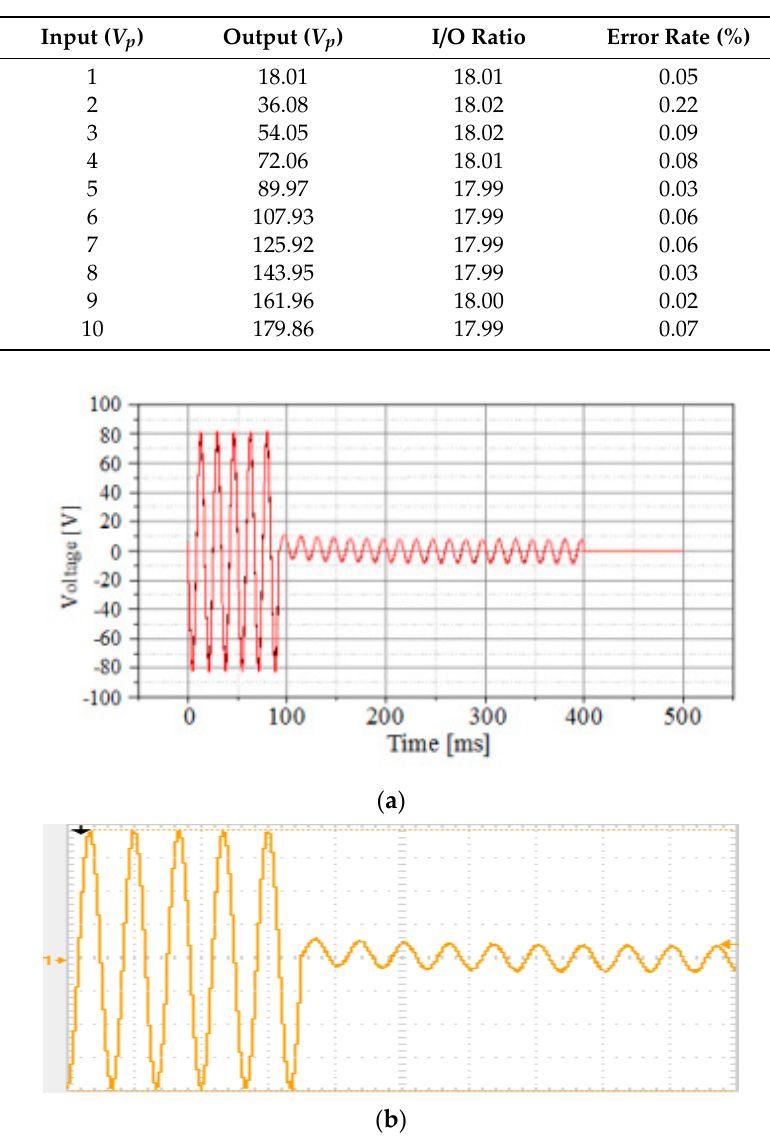
Figure 10. COMTRADE Output waveform test: ( a ) COMTRADE input waveform; ( b ) Simulator output waveform (voltage: 20 V/Div, time: 25 ms/Div).